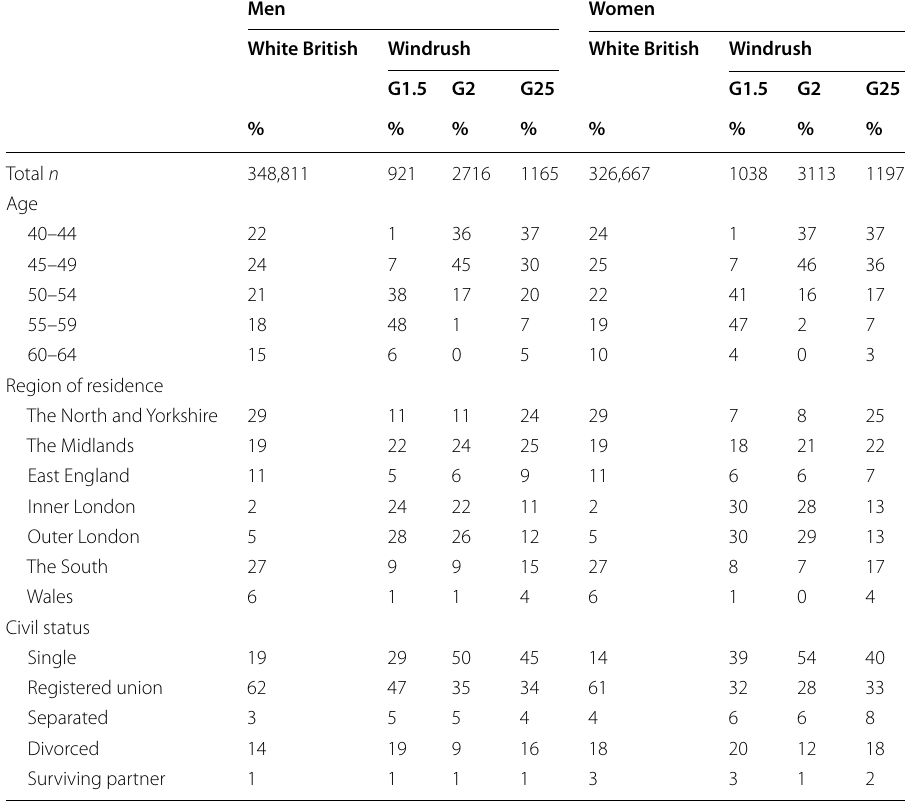
Table 3 Distribution of core demographic and geographic variables by generation and sex. Source : Authors’ calculations based upon 5% microdata sample of resident population of England and